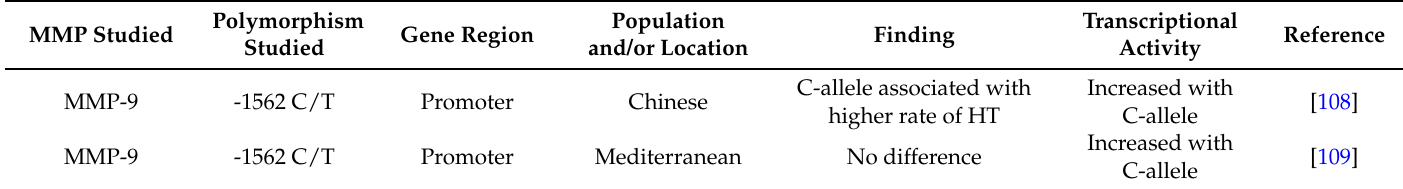
Table 4. MMP Polymorphism relation to hemorrhagic